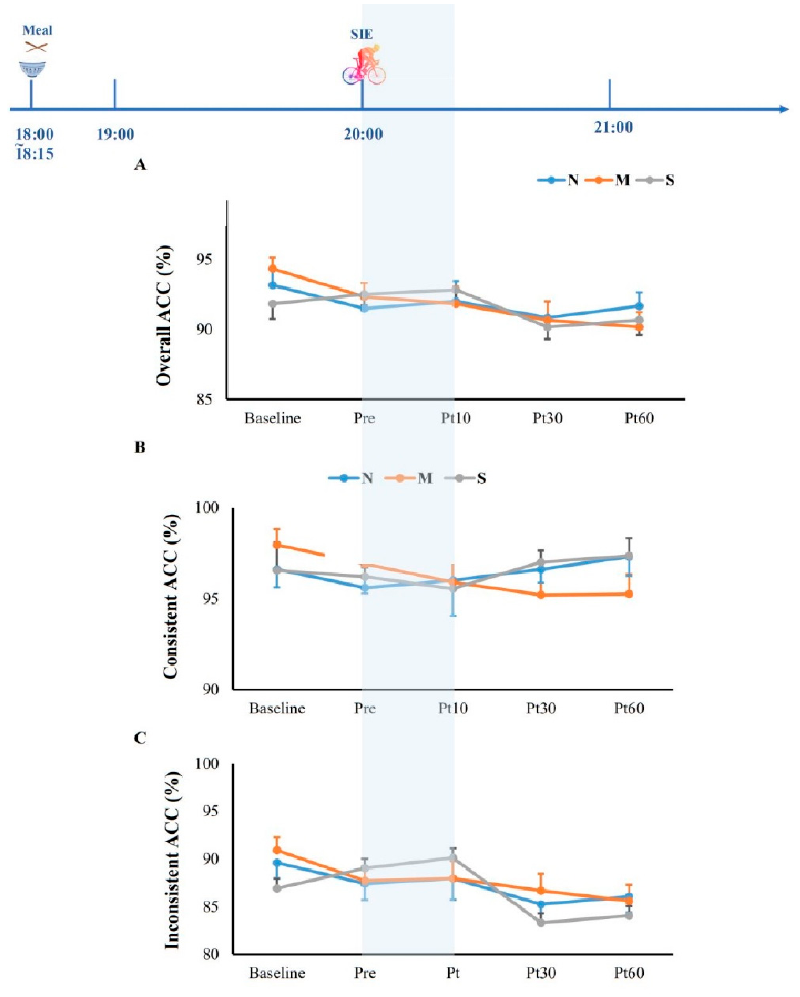
Figure 4. Overall ( A ), congruent (C-ACC, B ), and incongruent accuracy (INC-ACC, C ) in the Stroop test in responses to sprint interval exercise (SIE) under normoxia (20.9% O 2 ) and hypoxia (15.4%O 2, and 11.2%). The shaded part indicates oxygen condition. N: SIE in normoxia; M: SIE in moderate